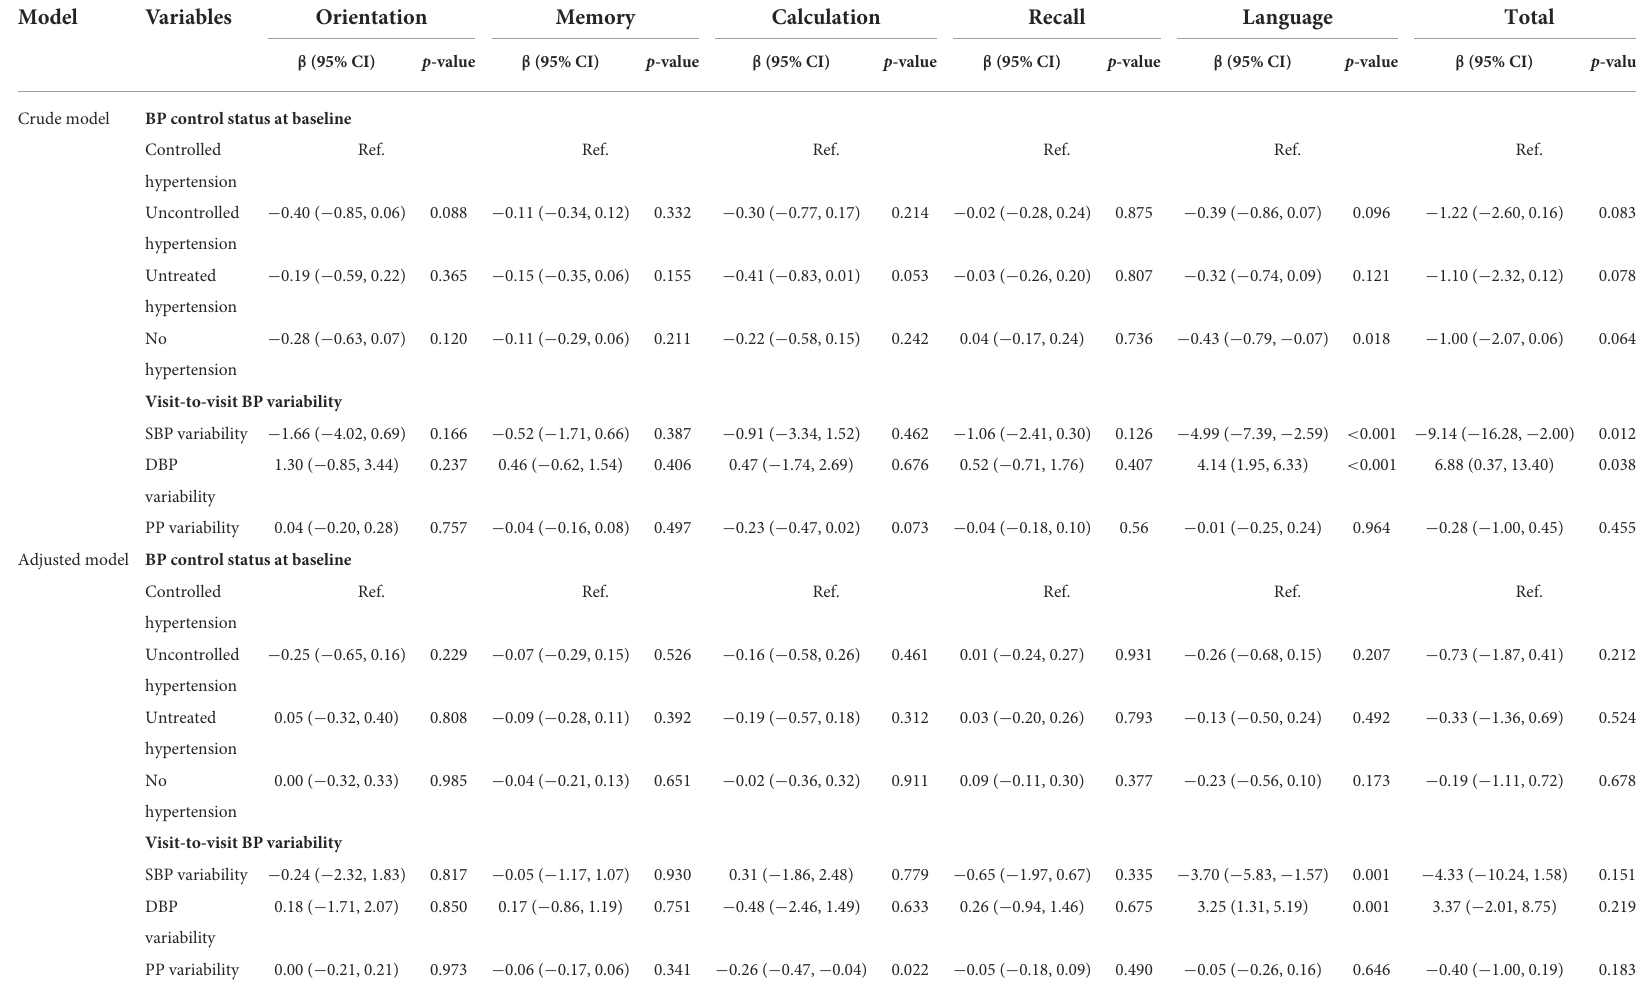
TABLE 2 General linear model for association between BP control status at baseline, visit-to-visit BP variability and cognitive scores in the mid-old